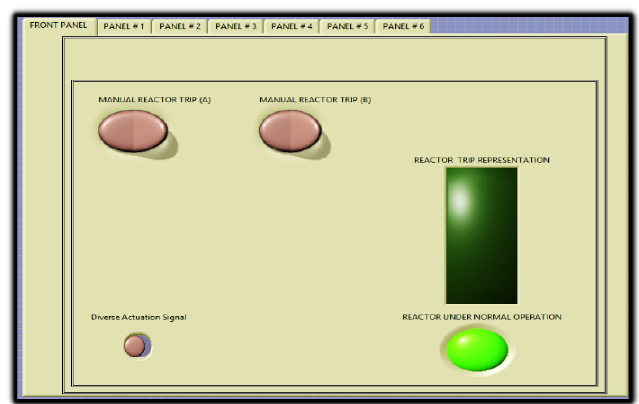
Fig. 8. ACP1000 normal and abnormal reactor operation display system in LabVIEW